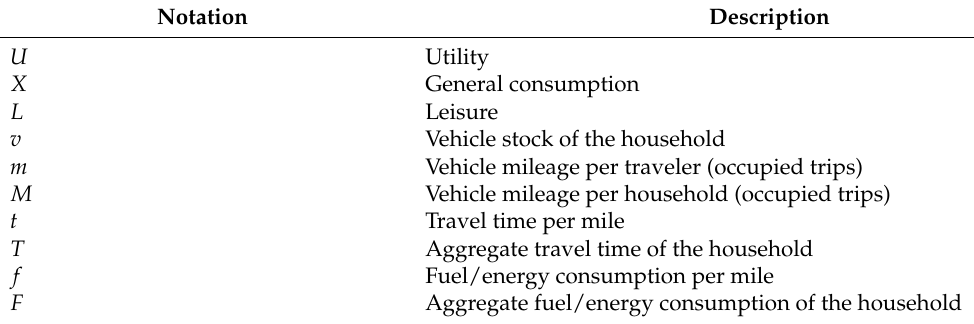
Table 2. Notational